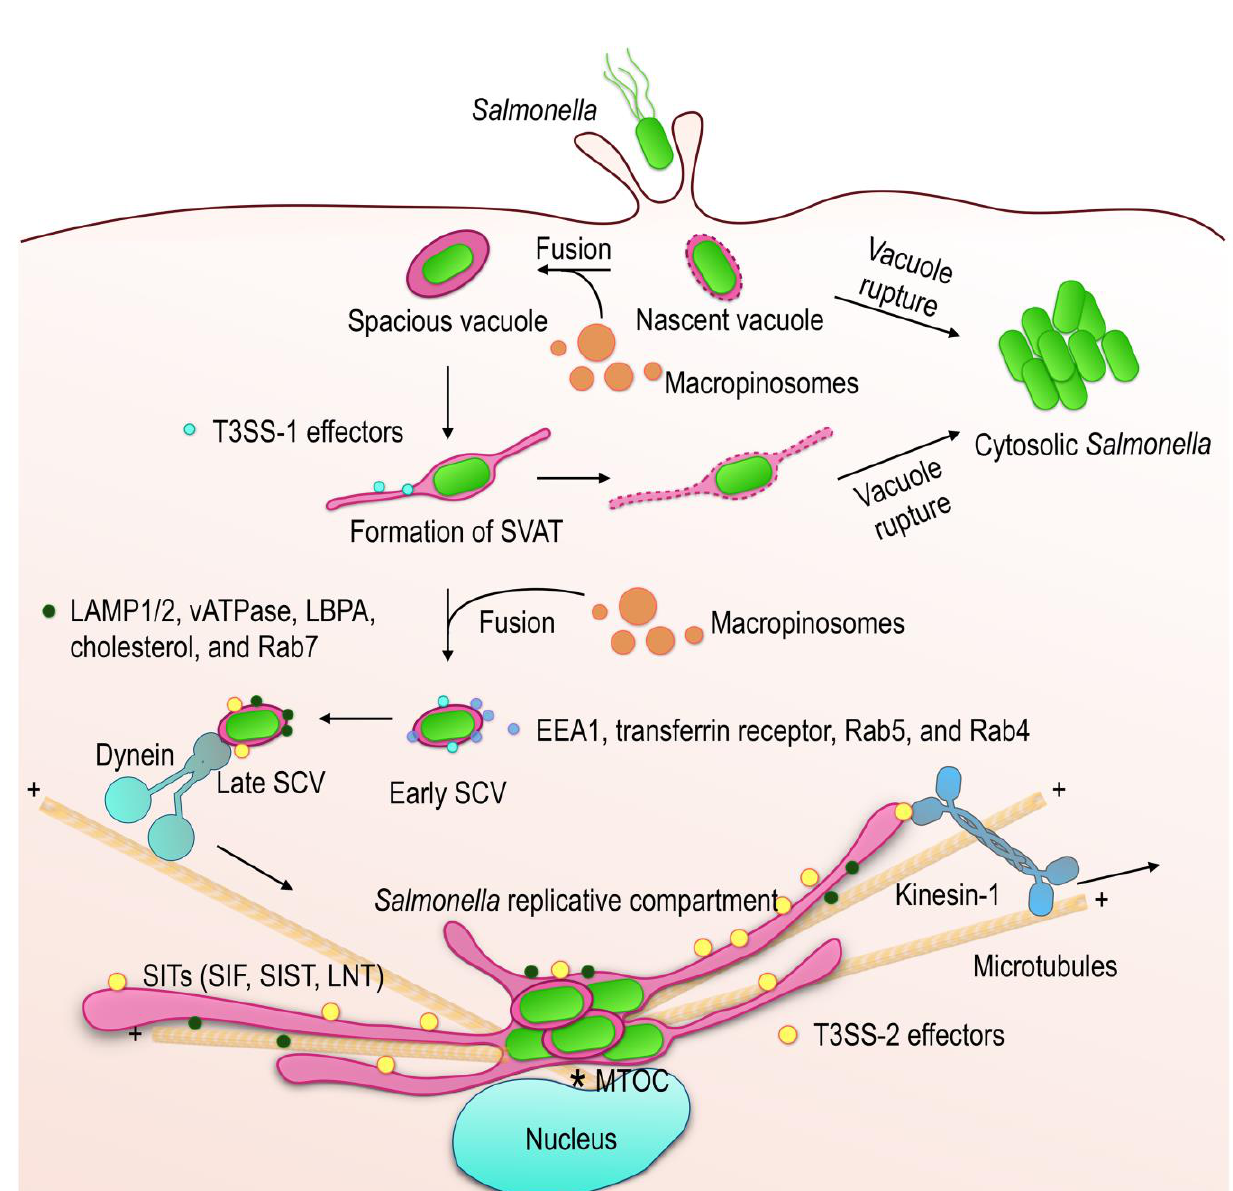
FIGURE 1: Maturation of the Salmonella -containing vacuole. Salmonella is able to infect non-phagocytic cells through the activity of effec- tors injected into the cell by T3SS-1. The formation of membrane ruffles allows entry into the cell and induces the formation of macropi- nosomes. The nascent vacuole is weakened by the presence of T3SS-1 and prone to rupture (5 - 20% of bacteria). Salmonella replicates rapid- ly in the cytosol of epithelial cells. Fusion of the nascent vacuole with macropinosomes increases its volume (spacious vacuole) and stabilizes it. Spacious vacuoles undergo further membrane remodeling, including the formation of SVAT with the help of the T3SS-1 effectors (south sea blue dots) and the host proteins SNX1/3. SVAT formation promotes vacuole rupture if membrane loss is not compensated by fusion activ- ity with macropinosomes. The Early SCV is characterized by the presence of early endosomal markers (light blue dots). Its maturation is marked by the loss of early endosomal markers, the acquisition of late endosomal markers (dark green dots) and a shift of the SCV from the cell periphery to the MTOC region. Changes in the content and physico-chemical properties of the SCV, in particular the drop in its pH, induce the expression of T3SS-2 and its effectors (yellow dots). These allow the establishment of the replicative compartment whose membrane is very similar to that of the lysosomes. During the replication phase, the SCVs remain in the juxtanuclear region and are associated with mem- brane tubules (SITs), of the same composition, that stretch into the cell, supported by the microtubules and under the action of associated molecular OPEN ACCESS | www.microbialcell.com